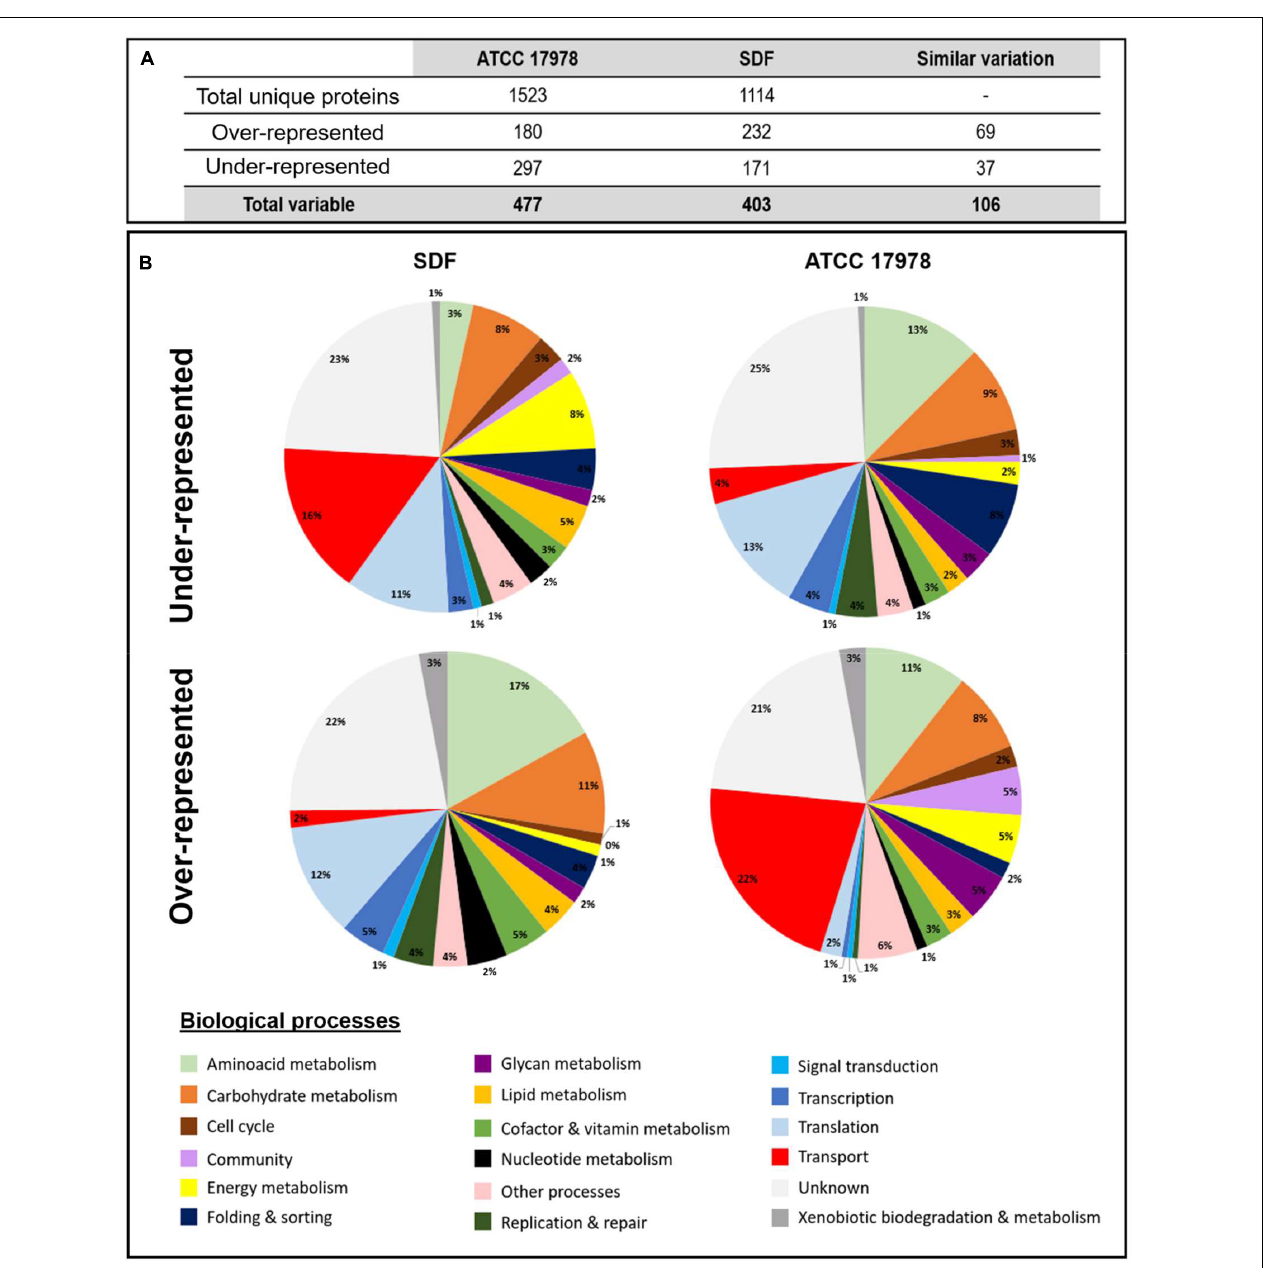
FIGURE 1 | Proteomic analyses of solid–liquid (S-L) biofilms formed by A. baumannii ATCC 17978 and SDF strains compared to their planktonic counterparts. (A) Number of proteins identified by proteomic analyses of A. baumannii ATCC 17978 and SDF strains and number of proteins with modified abundance in S-L biofilms compared to their planktonic counterparts. (B) Classification of these differentially represented proteins from A. baumannii SDF (left) and ATCC 17978 (right) according to their biological processes using the kyoto encyclopedia of genes and genomes (KEGG) pathway.